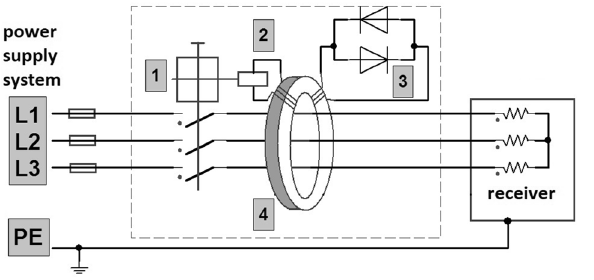
Figure 3. Residual Current Device with a Ferranti coil: 1—lock, 2—differential release, 3—anti-parallel diodes, 4—Ferranti coil 9 .